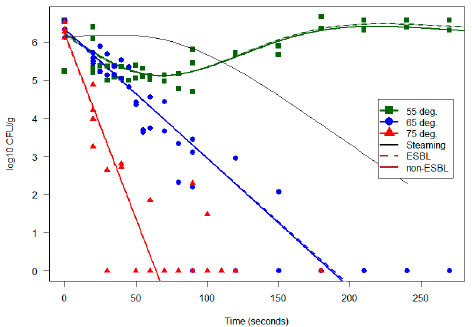
Figure 5. Concentrations (log(10) cfu/g) of E. coli and ESBL-producing E. coli during heat treatment in inoculated mussel flesh in constant-temperature water baths at 55 °C (green), 65 °C (blue) and 75 °C (red). ESBL and non-ESBL-producing E.coli inoculates are shown as solid and broken lines respectively. Only one line indicates overlap.